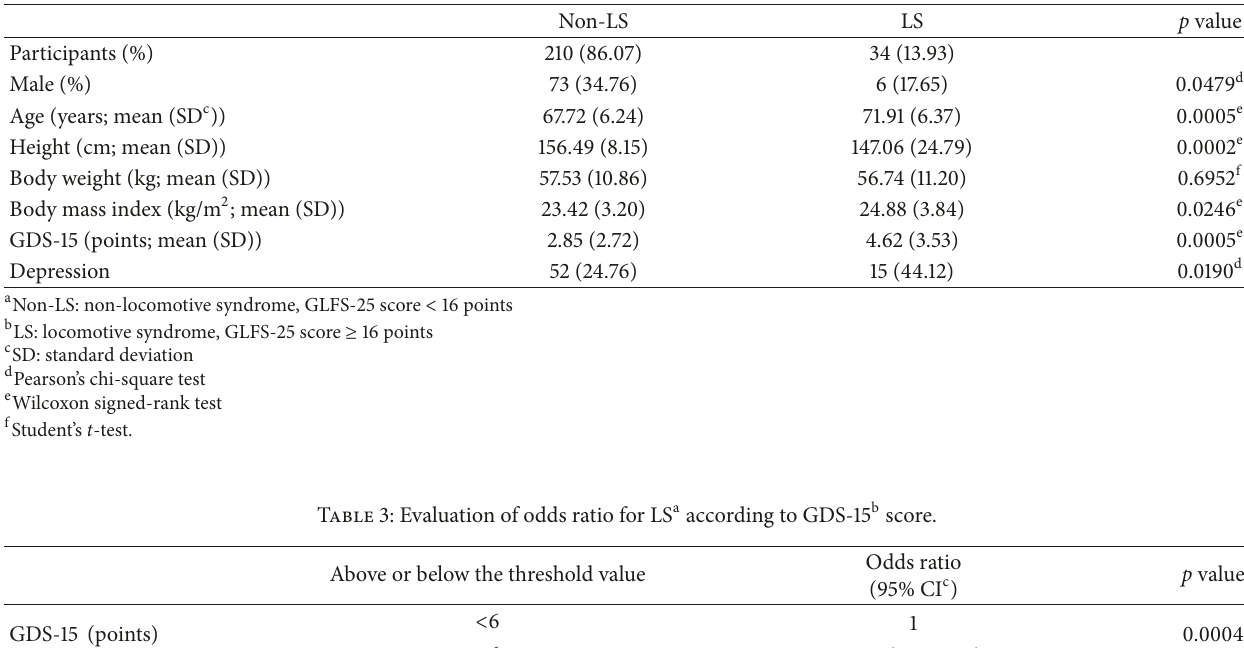
Table 2: Comparison of characteristics between the non-LS a and LS b groups.